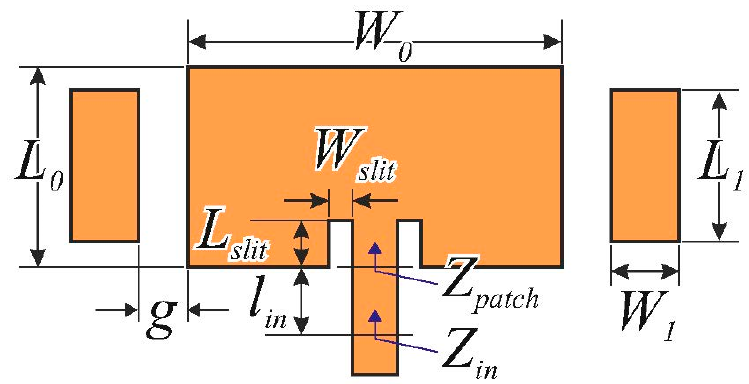
Figure 5. Layout of the proposed harvesting antenna.